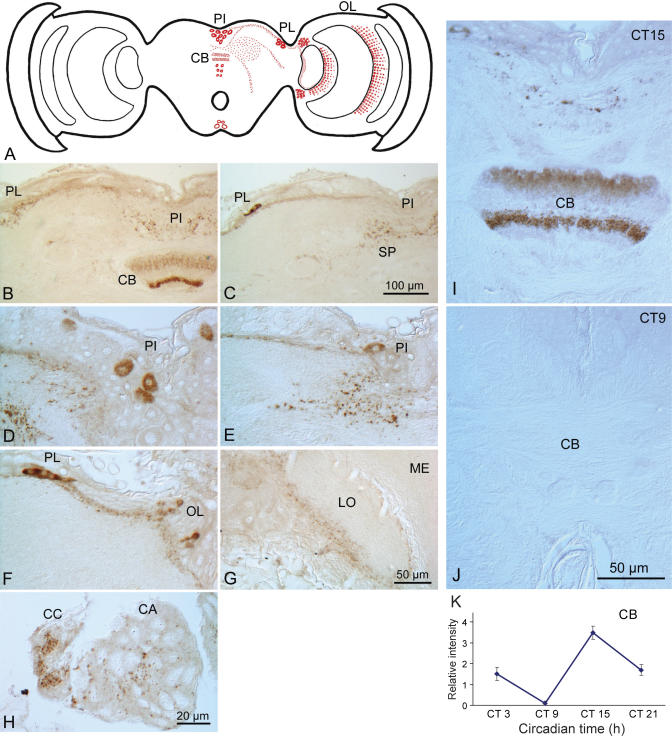
CRY2 Fiber Pathways in Monarch Brain(A) Schematic representation of frontal section illustrating the topology of CRY2 fibers at CT 15 using antibody CRY2-R42. A similar pattern of CRY2 fiber staining was found using antibody CRY2-GP51 (see Figure S13). PI, pars intercerebralis; PL, pars intercerebralis; OL, optic lobe; CB, central body.(B) CRY2 staining in central body (CB). PL, pars lateralis; PI, pars intercerebralis.(C–E) CRY2 fibers between PL and PI. SP, superior protocerebral bridge. CRY2 staining was not visible in central body on this section because the section is cut at a different plane.(F and G) CRY2 fibers between pars lateralis and optic lobe (OL); LO, lobula; ME, medulla.(H) CRY2 staining in corpora cardiaca (CC) and corpora allata (CA).(I and J) Circadian oscillation of CRY2 staining in the central complex. (I) CRY2 staining in upper and lower central body of the central complex at CT 15. (J) CRY2 staining in upper and lower central body of the central complex at CT 9.(K) Semiquantitative assessment of CRY2 staining in central body (CB) over the circadian day. Each value is mean ± SEM of five animals. Similar results were found in a replicate experiment using either CRY2-R42 or CRY2-GP51.